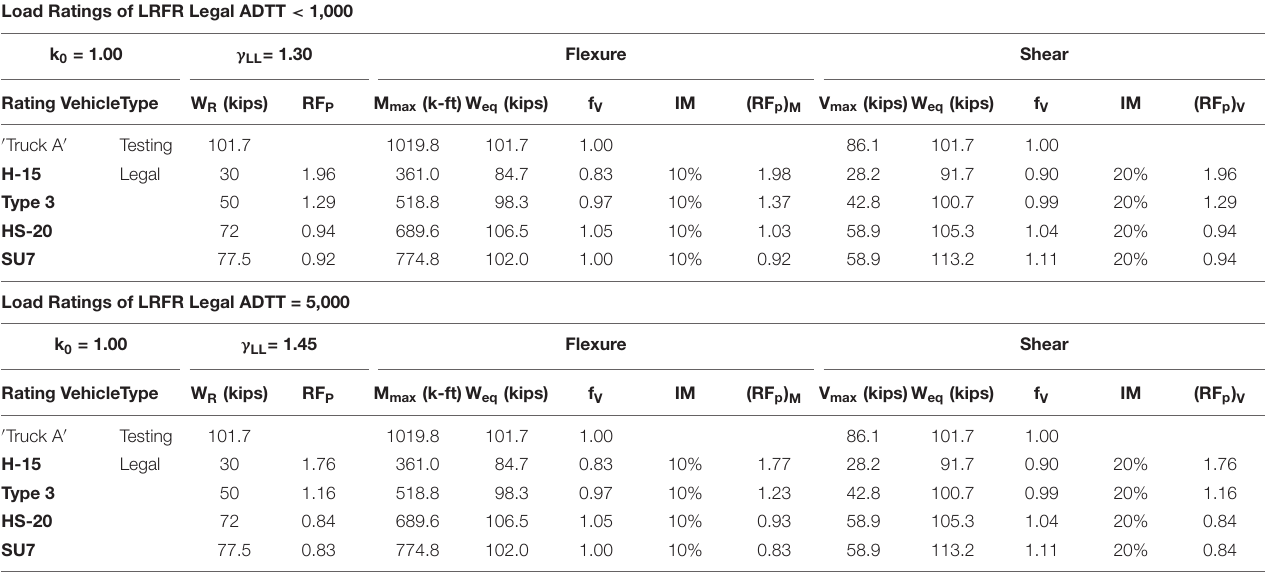
f y = yield strength of non-prestressed reinforcement (ksi) = 40 ksi. f pe = effective stress in prestressing steel after losses = (0.6) (250 ksi) = 150 ksi. β = angle of draped prestressing strands with respect to horizontal axis = 7 ◦